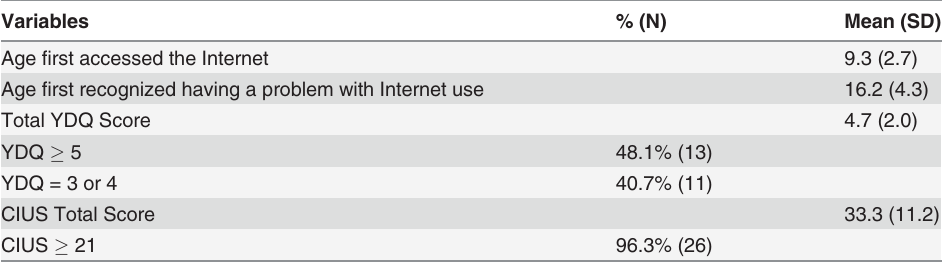
Table 2. Internet Use Characteristics of 27 Participants Who Self-Reported Problem Internet